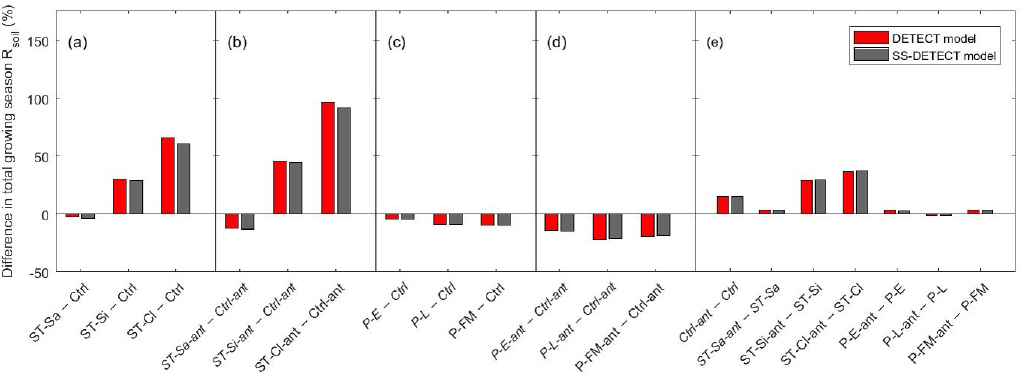
Figure 4. Differences of total growing season (April–September) soil respiration ( R soil ) as predicted by the non-steady-state (DETECT) and steady-state (SS-DETECT) models, for different pairs of scenarios. Comparisons are grouped so that they quantify the effects of (a) soil texture without antecedent effects, (b) soil texture with antecedent effects, (c) precipitation without antecedent effects, (d) precipitation with antecedent effects, and (e) antecedent effects. See Table 2 for descriptions of each